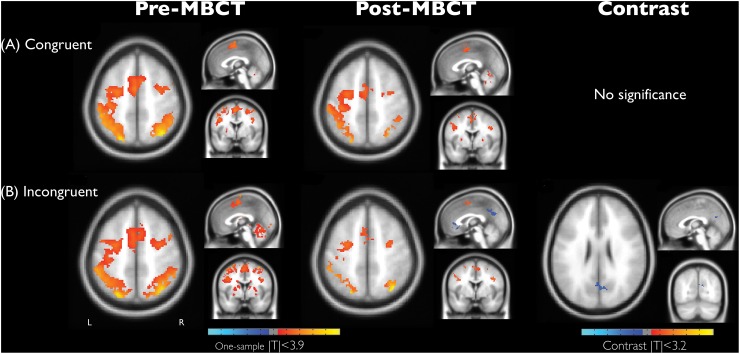
Brain activation maps associated with condition effect of (A) congruency and (B) incongruency and its difference and the intervention effect (before and after MBCT) in the numerical Stroop task on grief bereavement (AlphaSim corrected p < 0.05). Anatomical images were shown with coordinate location = [0, 0, 52] for one-sample t maps and [–2, –70, 26] for contrast maps. L, the left hemisphere.